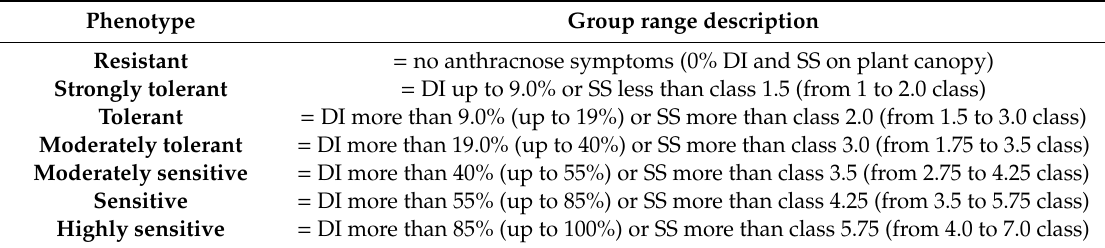
Table 1. Phenotype groups of mango susceptibility according to anthracnose disease incidence (DI) and severity